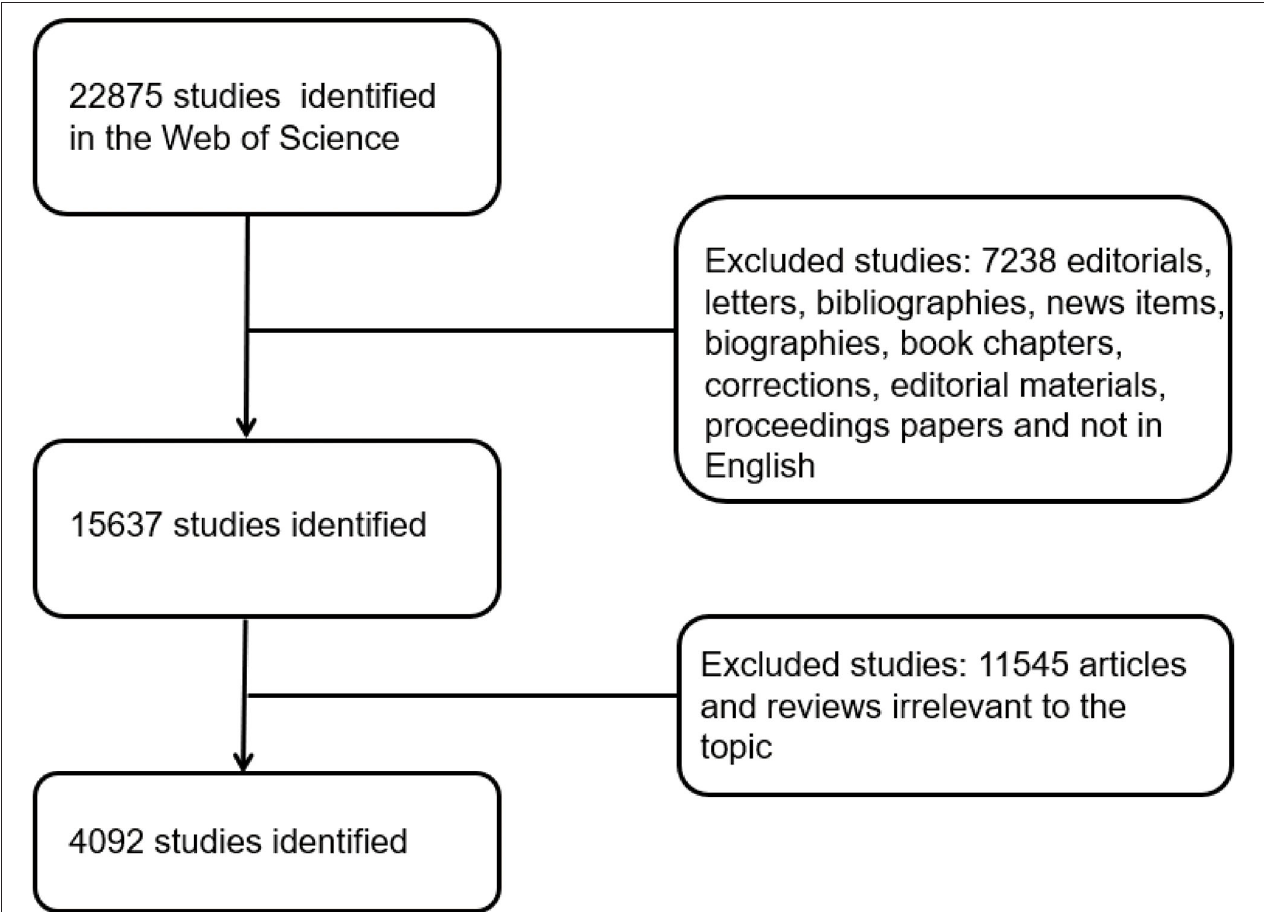
FIGURE 1 | Flow diagram of the inclusion process. The detailed process of screening and enrolment.